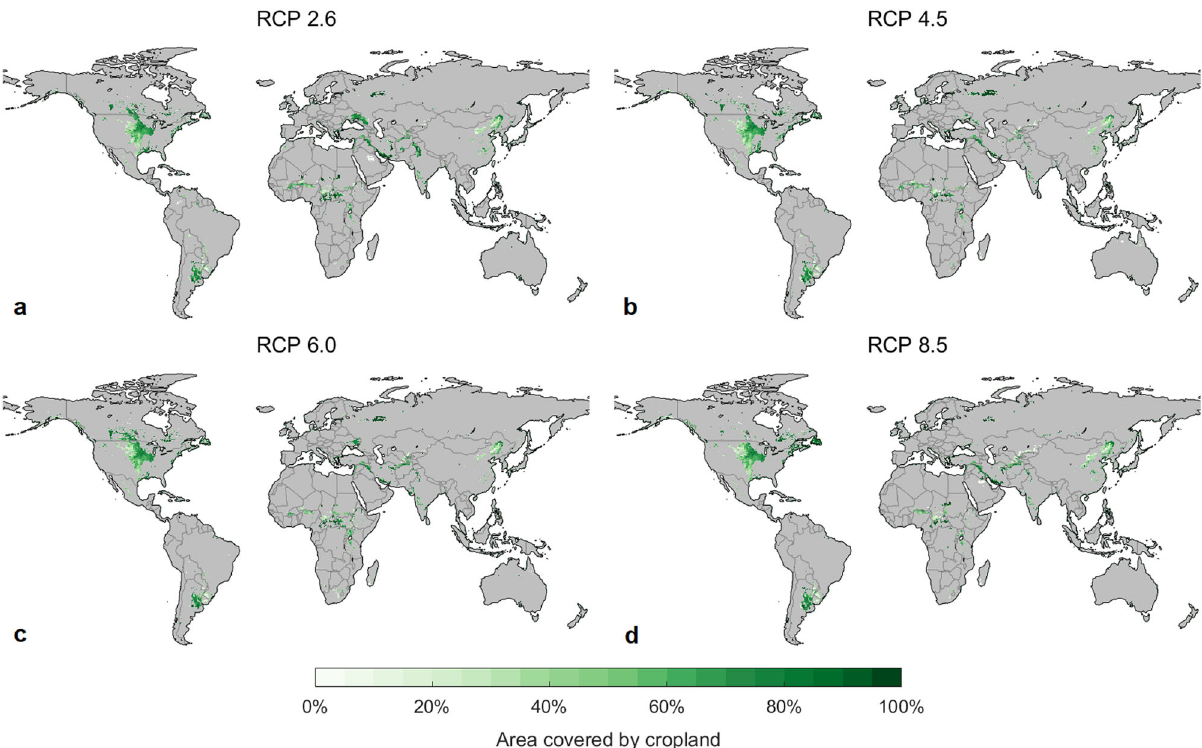
Fig. 2 Optimal distributions of global croplands for end-of-century climate. The maps show the equivalents of Fig. 1c based on potential yields projected for 2071 – 2100 climate under four alternative emission scenarios: RCP a 2.6, b 4.5, c 6.0, d 8.5. In each scenario, the production levels of individual crops are identical to current ones, given the lack of suitable future projections (see text). Maps of the distribution of the 25 individual crops for each climate scenario are shown in Supplementary Movie 3. Optimal cropland sites for relocation within national borders (i.e., equivalents of Fig. 1d) were not estimated, as the optimisation problem in this case is ill-de fi ned (see the “ Methods ”